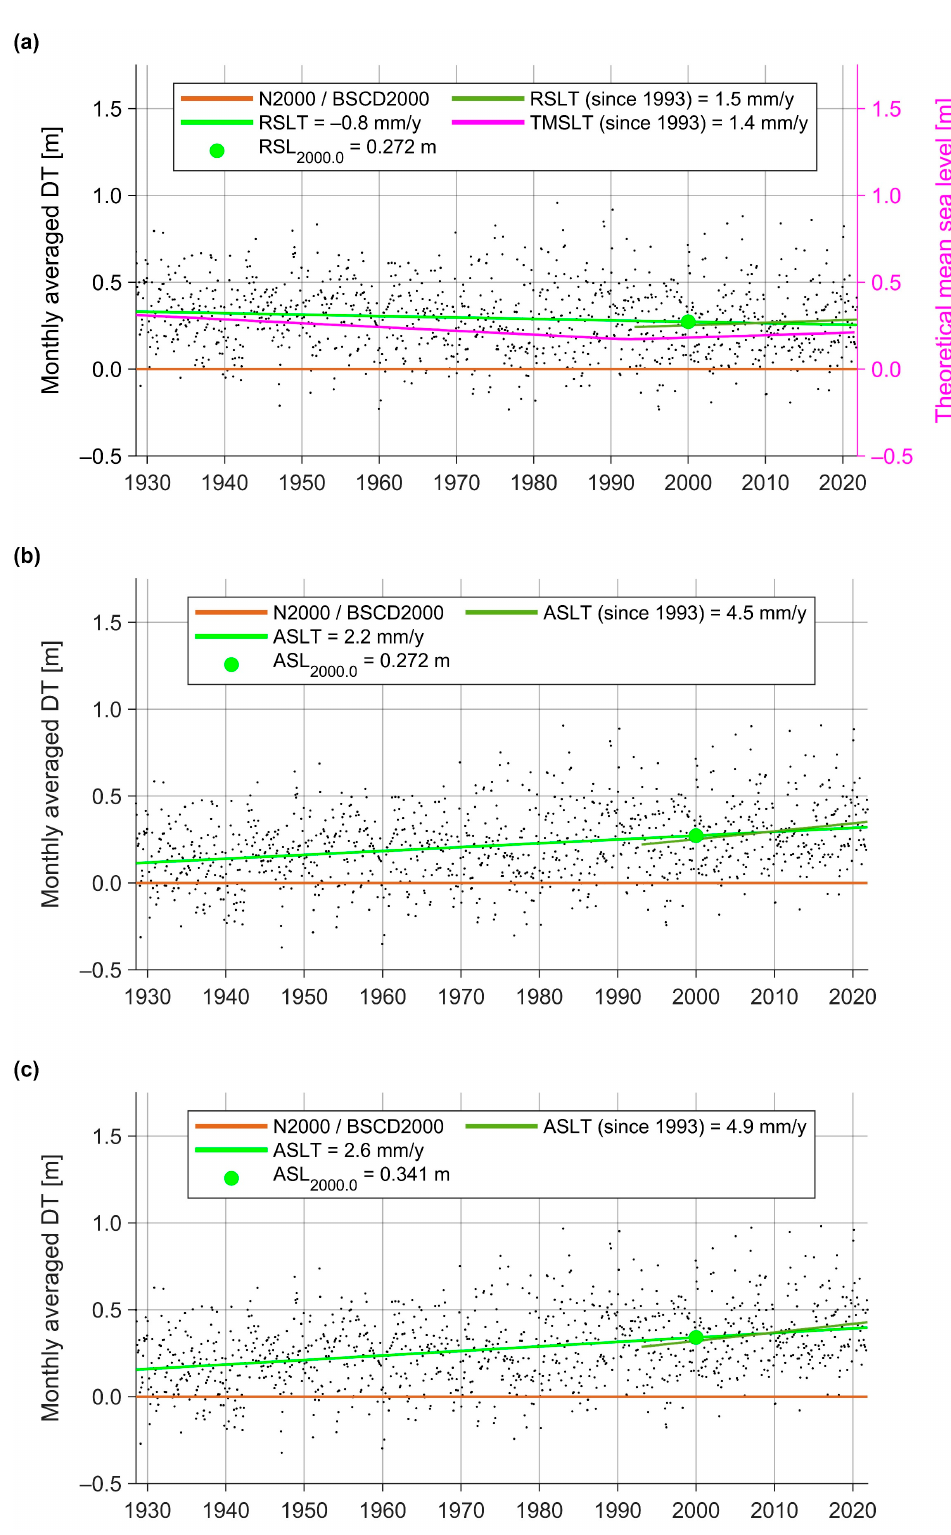
Figure 6. Monthly averaged ( a ) relative and ( b ) absolute DT of Hamina TG (cf. Figure 2 for its location) and the estimated sea level trends. In ( c ) are presented absolute DT and the estimated sea level trends containing purposefully induced errors (i.e., VLM geocentric and an arbitrary reference epoch 1980.0 are used).